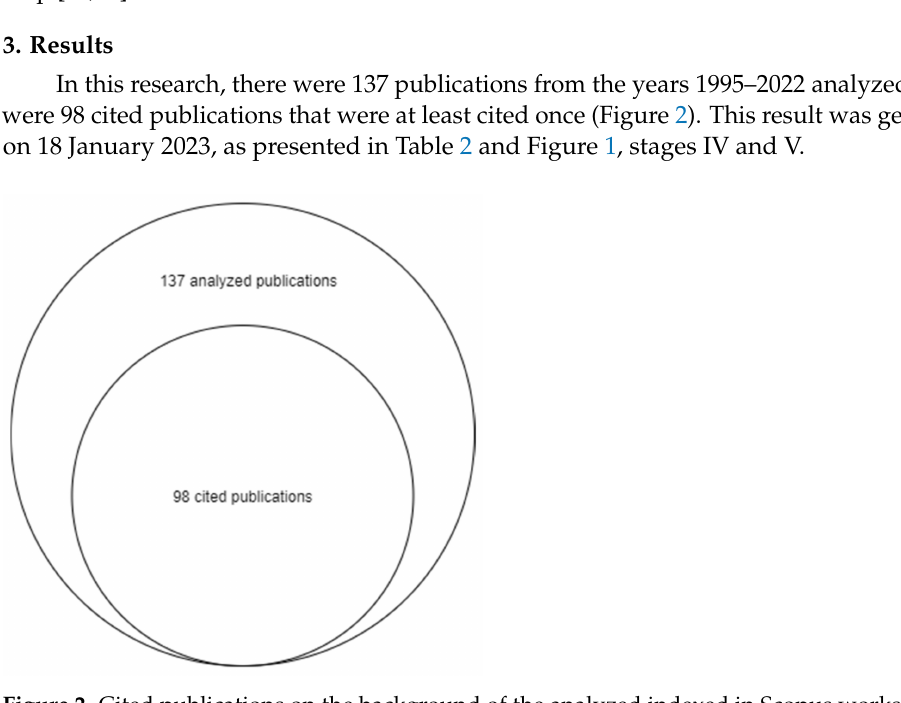
Figure 2. Cited publications on the background of the analyzed indexed in Scopus works. Source: Authors’